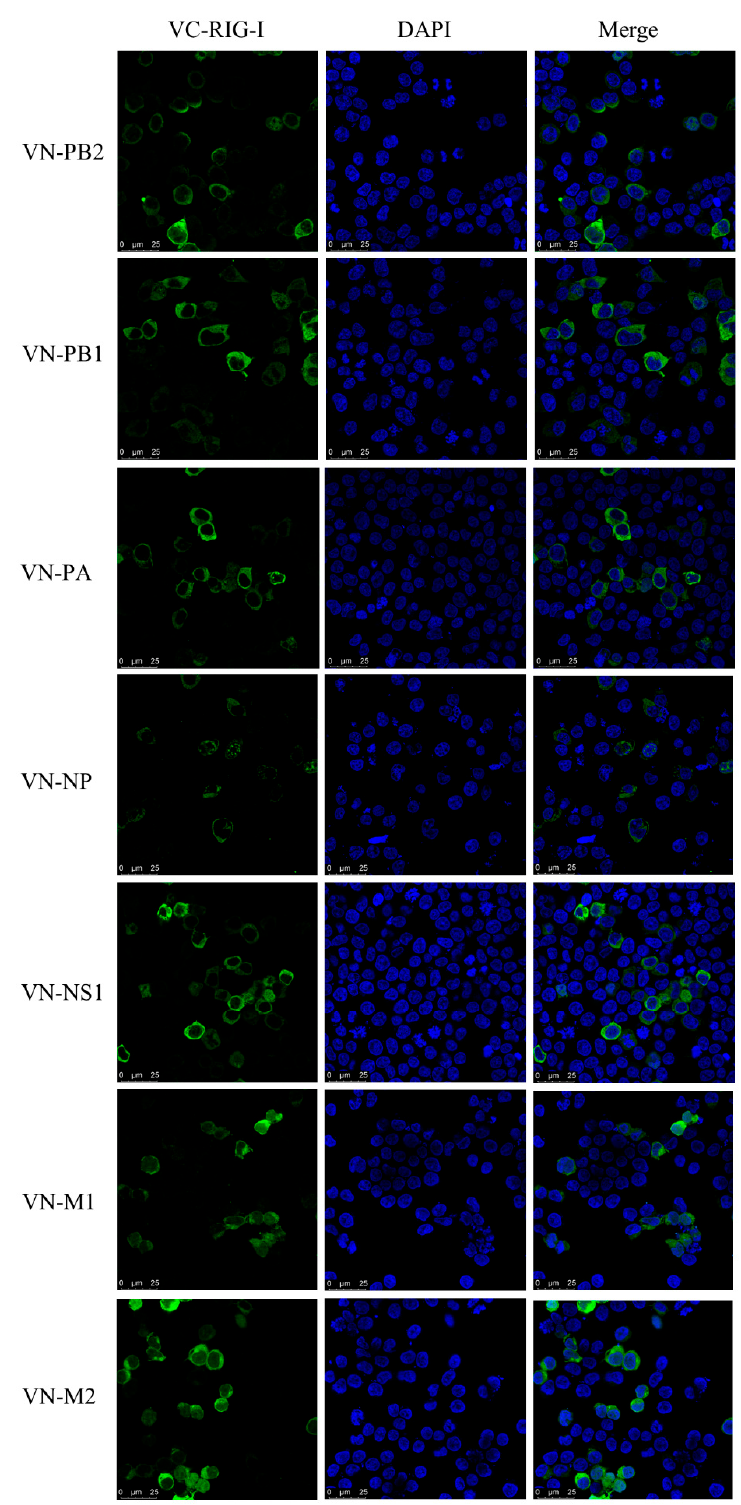
Figure 8. Interactions between CIV proteins and canine RIG-I detected by BiFC assay. BiFC analysis of the interaction between canine RIG-I protein (canine RIG-I with the C-terminal fragment of GFP) and CIV viral protein (PB2, PB1, PA, NP, NS1, M1, and M2 with the N-terminal fragment of GFP) in HEK 293T cells.